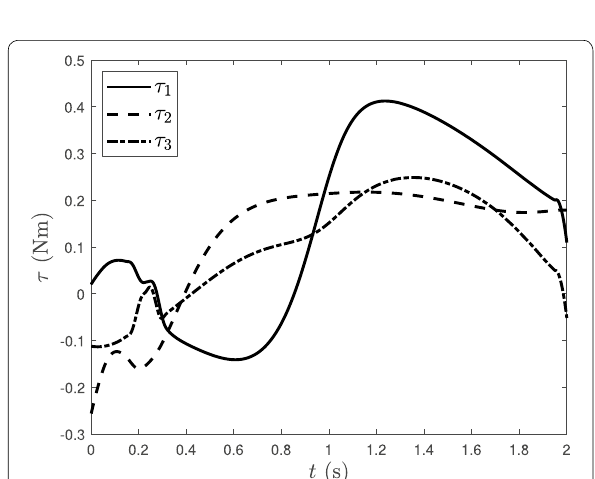
Fig. 17 Normal force at the contact interface of the soft tip and